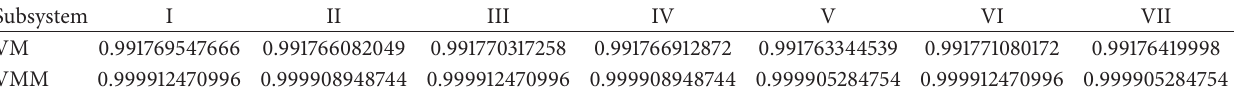
Table 5: SSAs of VSS under given parameter values in seven case studies.